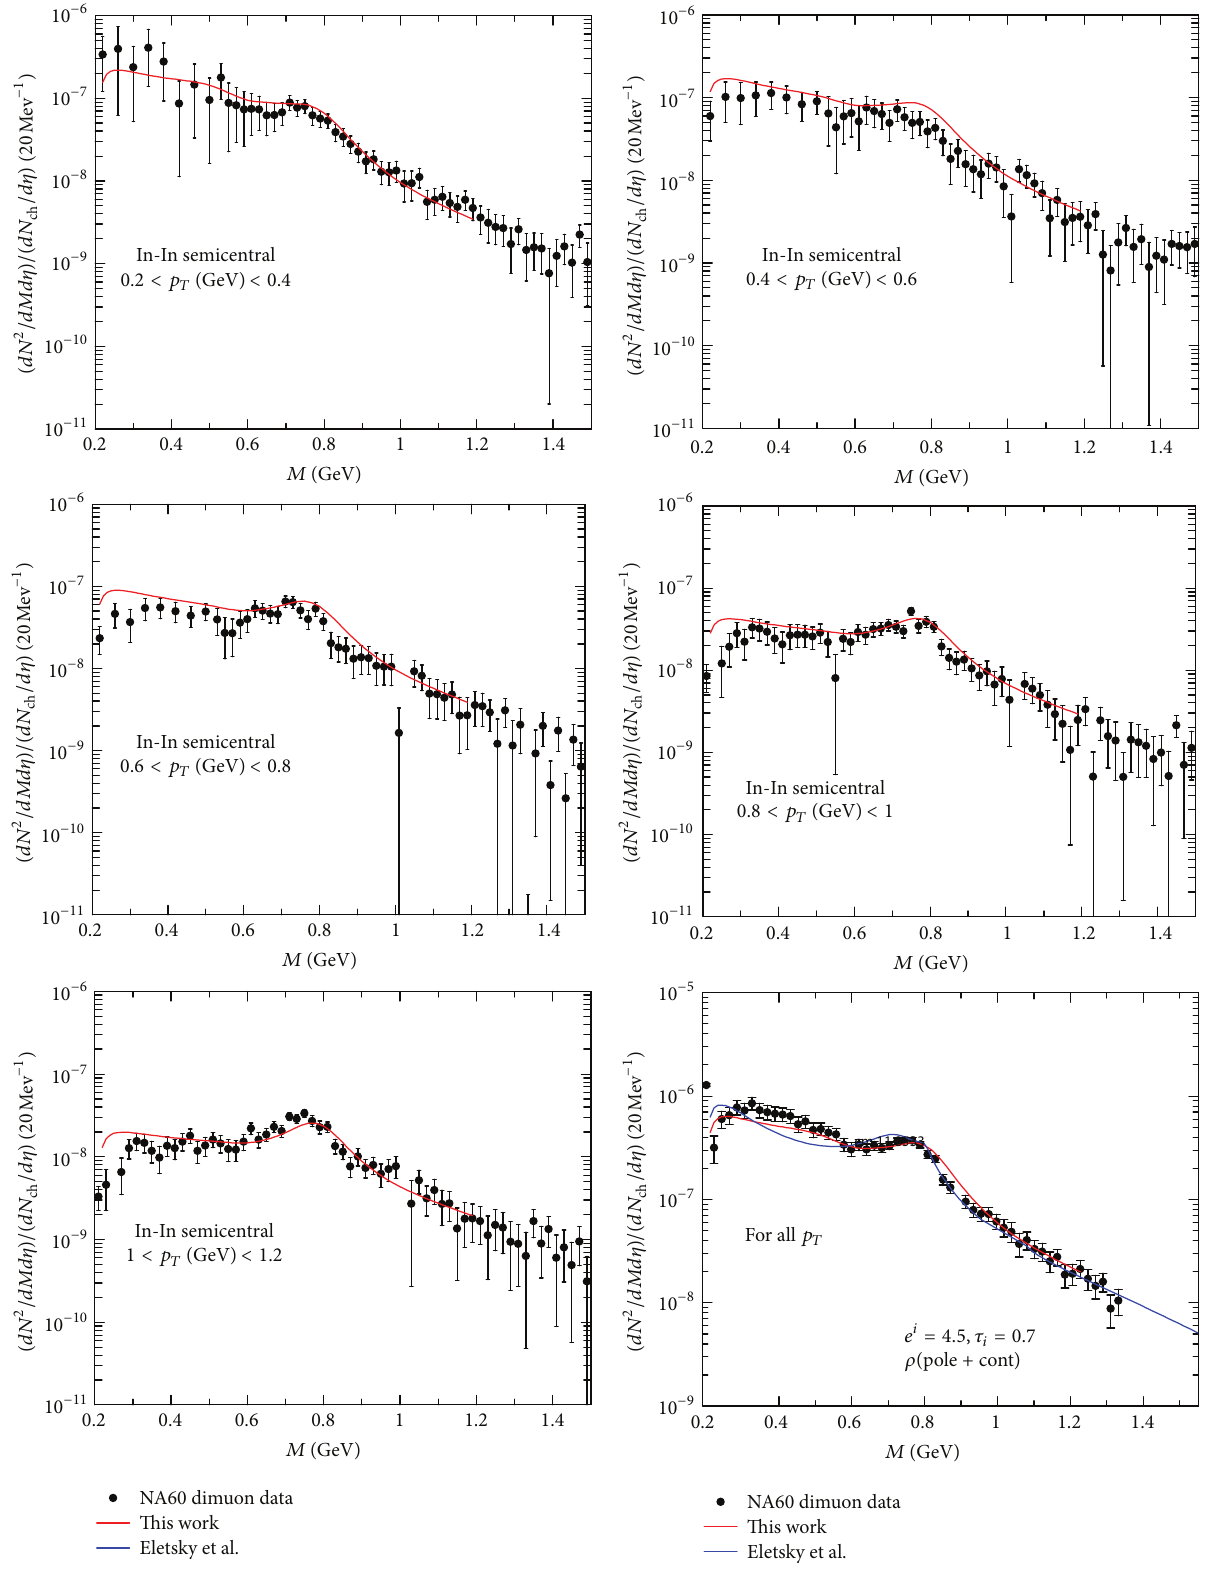
Figure 21: Dilepton invariant mass spectra for different 𝑝 𝑇 bins compared with the NA60